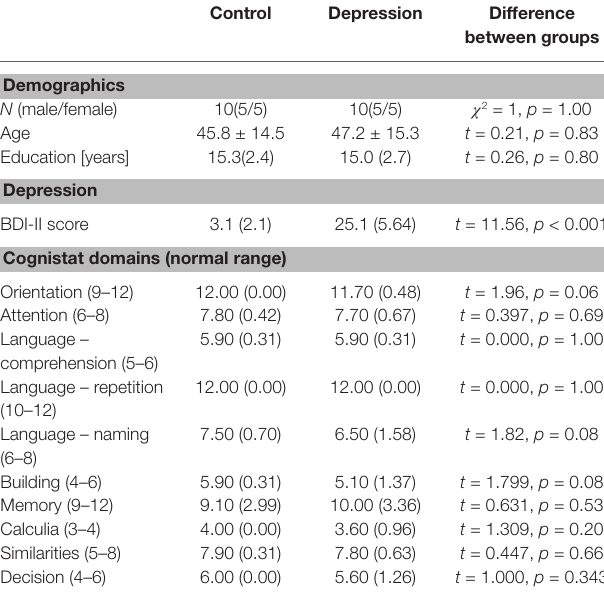
TABLE 1 | Demographic and baseline characteristics.